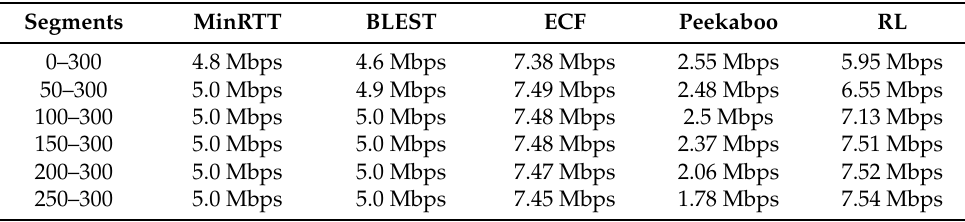
Table 2. Average video bitrate for each scheduler. In detail, it is the average of the data corresponding to the left segment range.